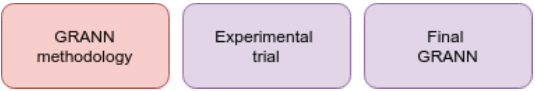
Figure 5. Final GRANN used to unfold the experimental neutron spectrum